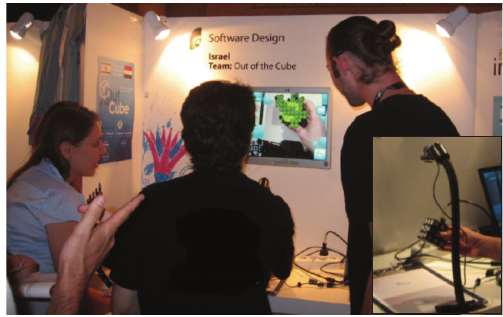
Figure 6: Users trying the system at Imagine Cup Expo.